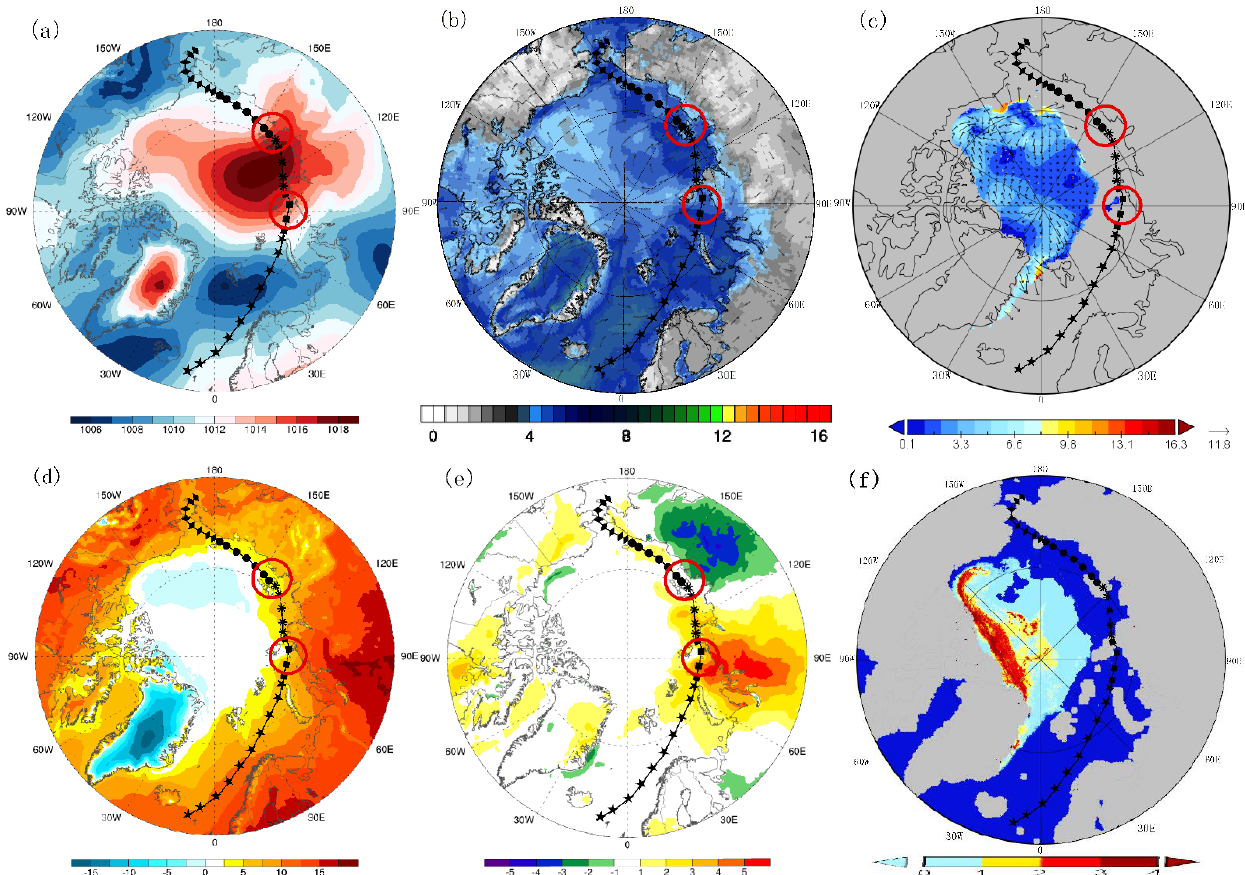
Figure 20. Distribution map of ( a ) sea level pressure (unit: hpa); ( b ) wind field (unit: m −1 ); ( c ) sea ice movement (unit: m −1 ); ( d ) temperature (unit: centigrades); ( e ) temperature anomaly (unit: centigrades) and ( f ) sea ice age (unit: year) in the Arctic summer in August 2020. (The red circles represent the special areas.)